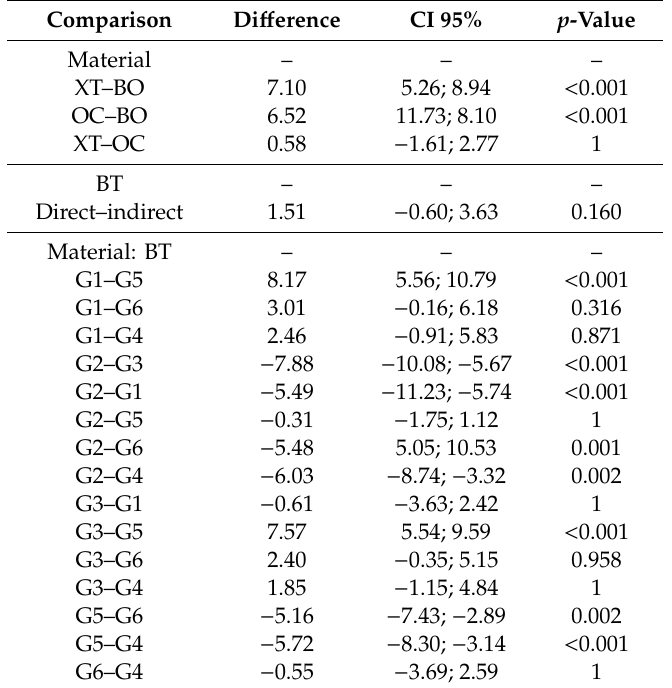
Figure 5. Bar diagram of ARI classification according to groups.